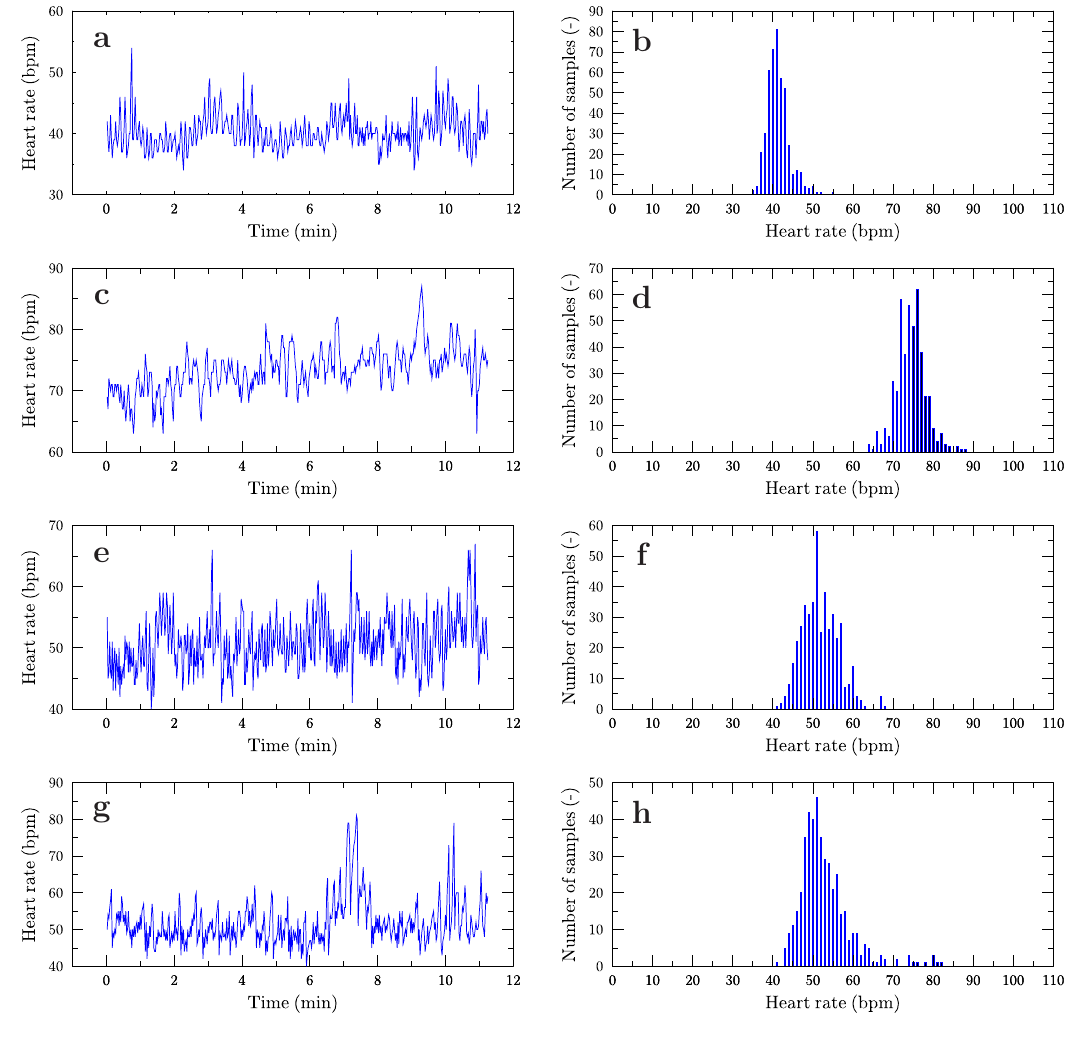
Figure 5. The ECG signal measured and the corresponding HR value distributions: ( a , b ) day 1, ( c , d ) day 2, ( e , f ) day 3, and ( g , h ) day 4.